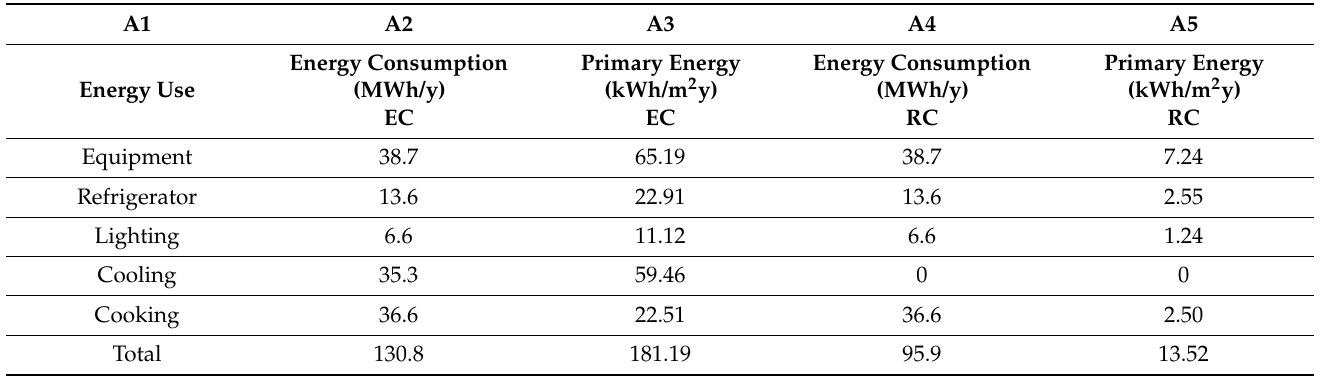
Table 7. Conversion of energy consumption and generation values into primary energy